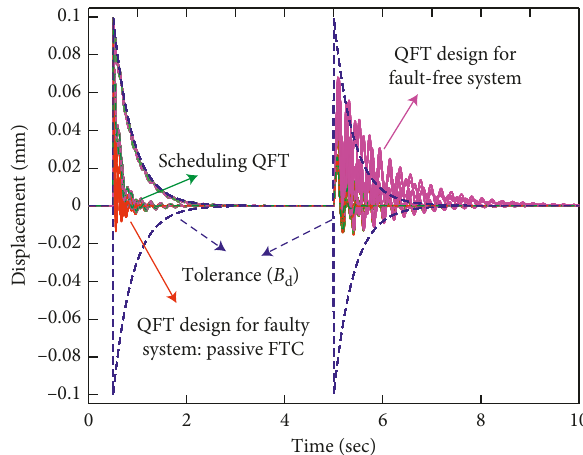
Figure 7: The closed-loop responses of the system (128 randomly selected plant from the plant set (5)) with the fixed fault at time t 5sec for case (i). “Magenta solid line” represents the fault-free (cid:29) design (G), “red dashed line” represents the faulty system controller ( G f ) response, and “green dashed-dotted line” represents proposed scheduling QFT.